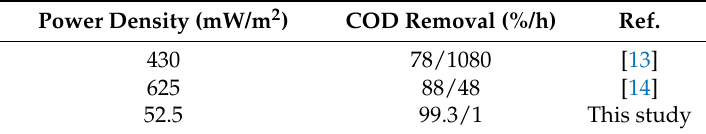
Table 1. Research studies using Bio-E-Fenton systems.